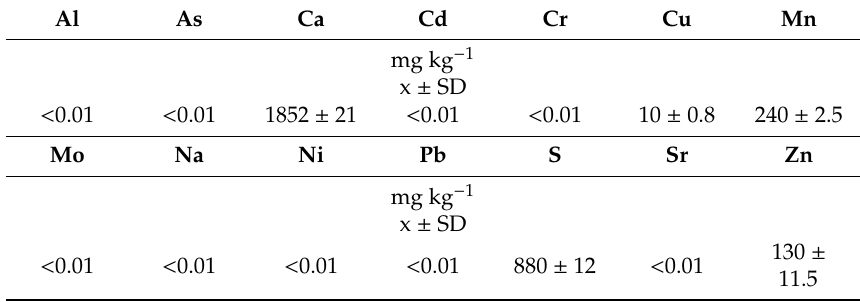
Table 2. The contents of selected macro- and micro-elements in the biochar generated from biomass. x—mean, SD—standard